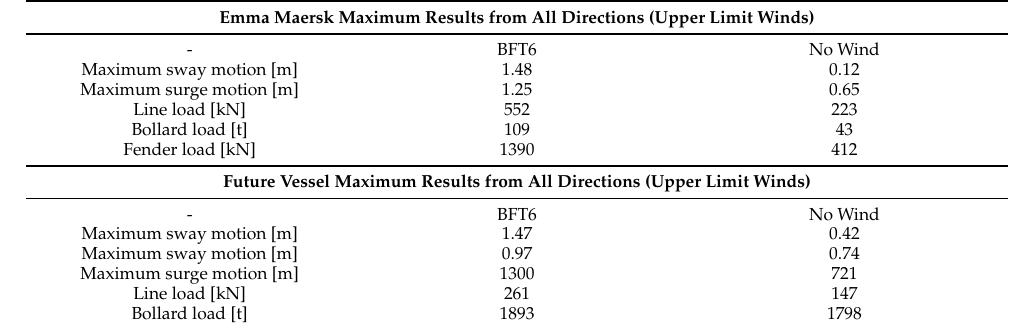
Table 6. Summary of the maximum motions and loads among all wind directions for BFT 6 and no wind for the Emma Maersk and the future vessel with the use of ShoreTension ® .